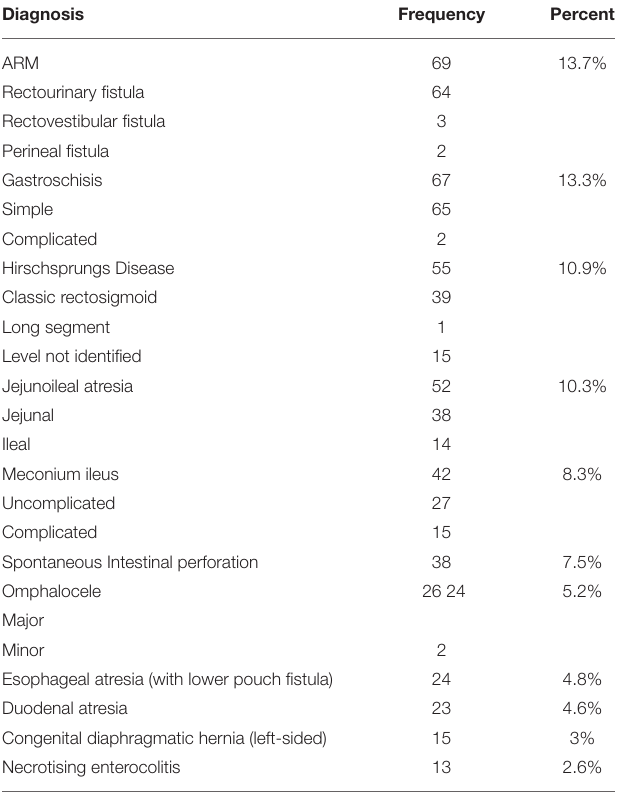
TABLE 1 | Common diagnoses of babies who expired.